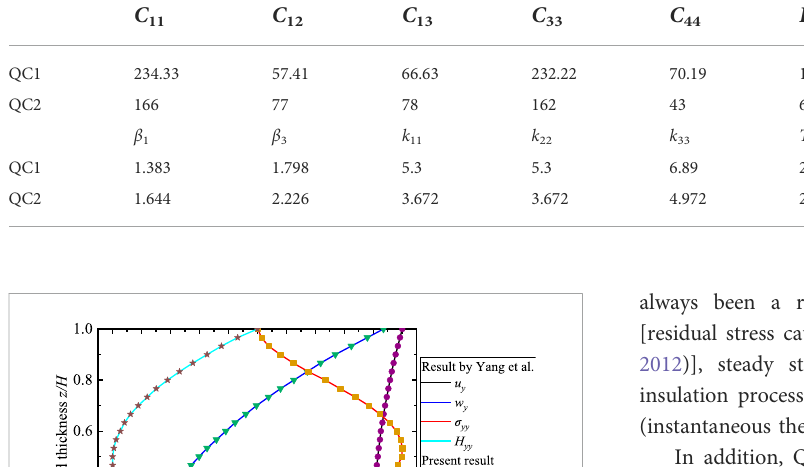
TABLE 1 Material properties (C, K, and R in 10 9 N/m 2 , β in 10 6 N K/m 2 , k in W K/m, T 0 in K, C e in J kg/K, ρ in kg/m 3 ).